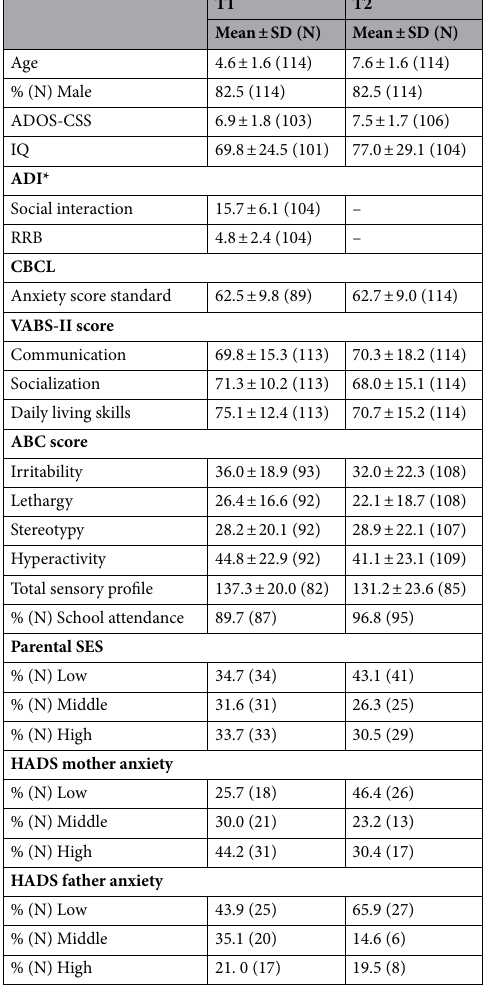
Table 1. Clinical characteristics of the sample at T1 and T2 (N = 114). *Assessed once during the development. SD standard deviation, ADOS CSS autism diagnostic observation schedule calibrate severity scale, CBCL Child Behavior Checklist, VABS-II Vineland second version, ABC Aberrant Behaviors Checklist, ADI-R autism diagnostic interview-revised, RRB restrictive repetitive behaviour, SES socioeconomic status, HADS The hospital anxiety and depression